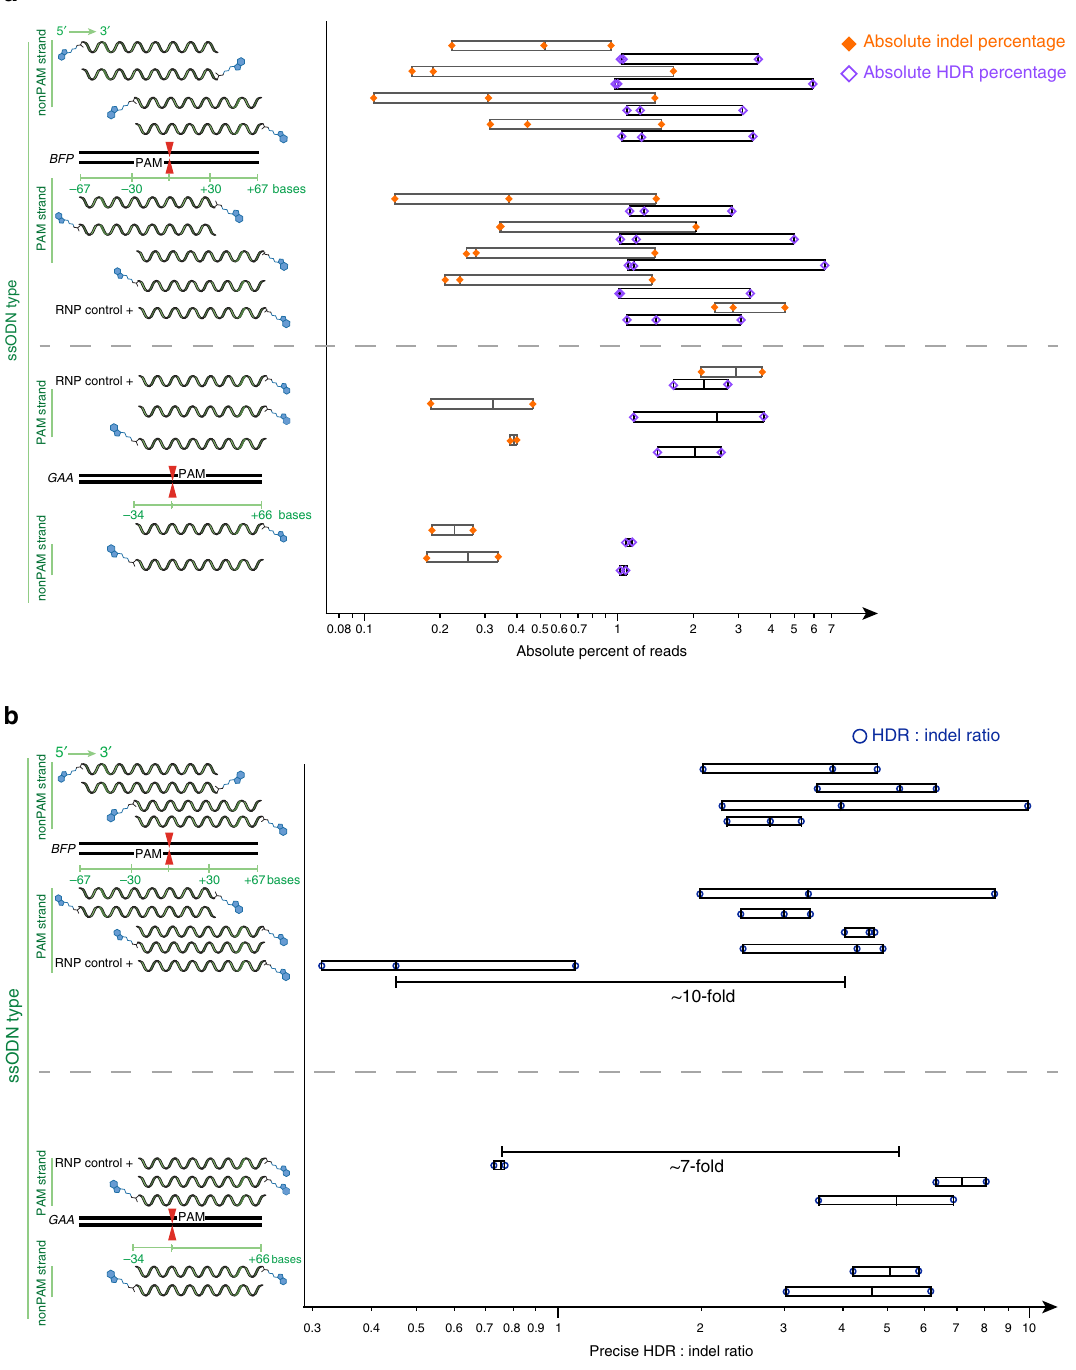
Fig. 4 ssODN asymmetry, strandedness and tether location minimally affects S1mplex gene editing. Left: ssODN design. Genomic sequence is denoted with black bars. sgRNA target strand and PAM is denoted by “ PAM ” inside genomic locus, while red triangles are the sgRNA cut site. ssODN length is measured around cut site either upstream ( − ) or downstream (+) as read by the reading frame. Biotin (blue hexagons) was attached to either the 5 ′ or 3 ′ end of the ssODN. ssODNs were identical in sequence to either the PAM or non-PAM sequence as read in a 5 ′ -3 ′ direction. RNP controls were standard sgRNAs plus corresponding ssODN. a Absolute NHEJ (orange diamonds) and HDR percentage (purple diamonds) as a function of total reads at two different loci in hPSCs using different ssODN designs. Each symbol represents a single replicate analyzed by deep sequencing 4 days after nucleofection into hPSCs. HDR levels were generally higher in each replicate than NHEJ levels. See also Supplementary Table 9. b Ratio of HDR:indel reads in deep sequencing using each ssODN combined with S1mplexes. Blue circles represent individual biological replicates. With each ssODN, S1mplexes increased the ratio of HDR:indel when compared to sgRNA controls, but no signi fi cant trends as to symmetry, sidedness, or biotin location were